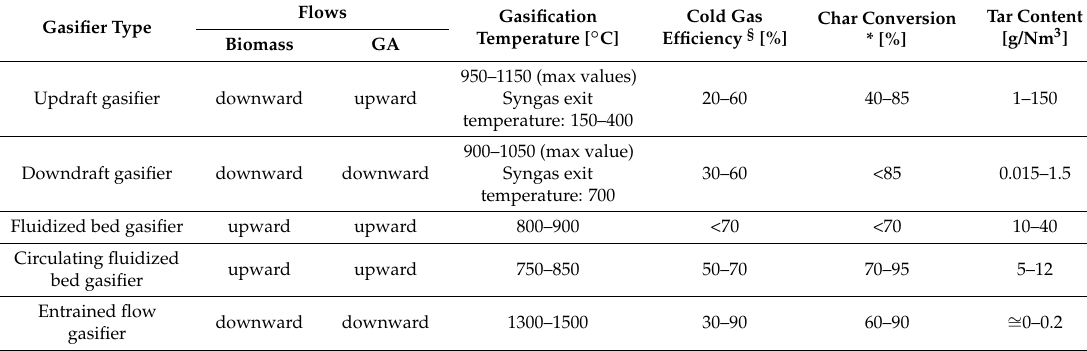
Table 7. Characteristics and performance of gasification reactors (adapted from